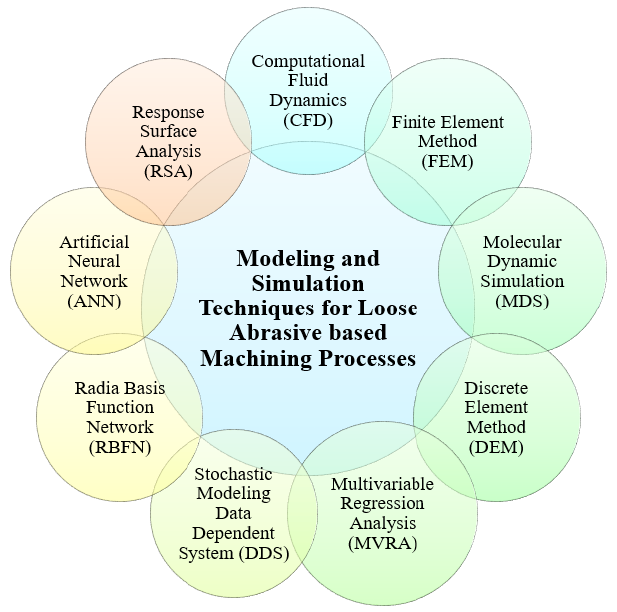
Figure 10. Modeling and simulation tools and techniques for “loose abrasive-based machining”.